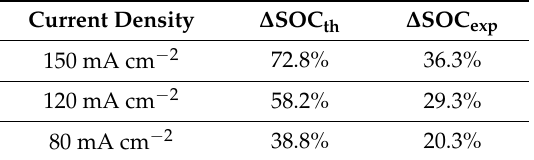
Figure 6. OCV contours at 5 s after termination of discharge at flow rate of 42 mL min − 1 at current density of 80 mA cm 2 at ( a ) normal flow and ( b ) reverse flow. Table 4. ∆ SOC exp and ∆ SOC th for the contour diagram shown in Figure